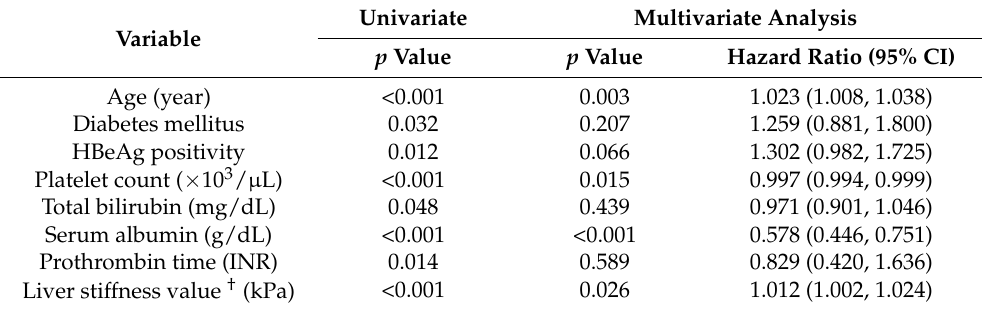
Table 3. Multivariate Cox regression analysis for the development of hepatocellular carcinoma.